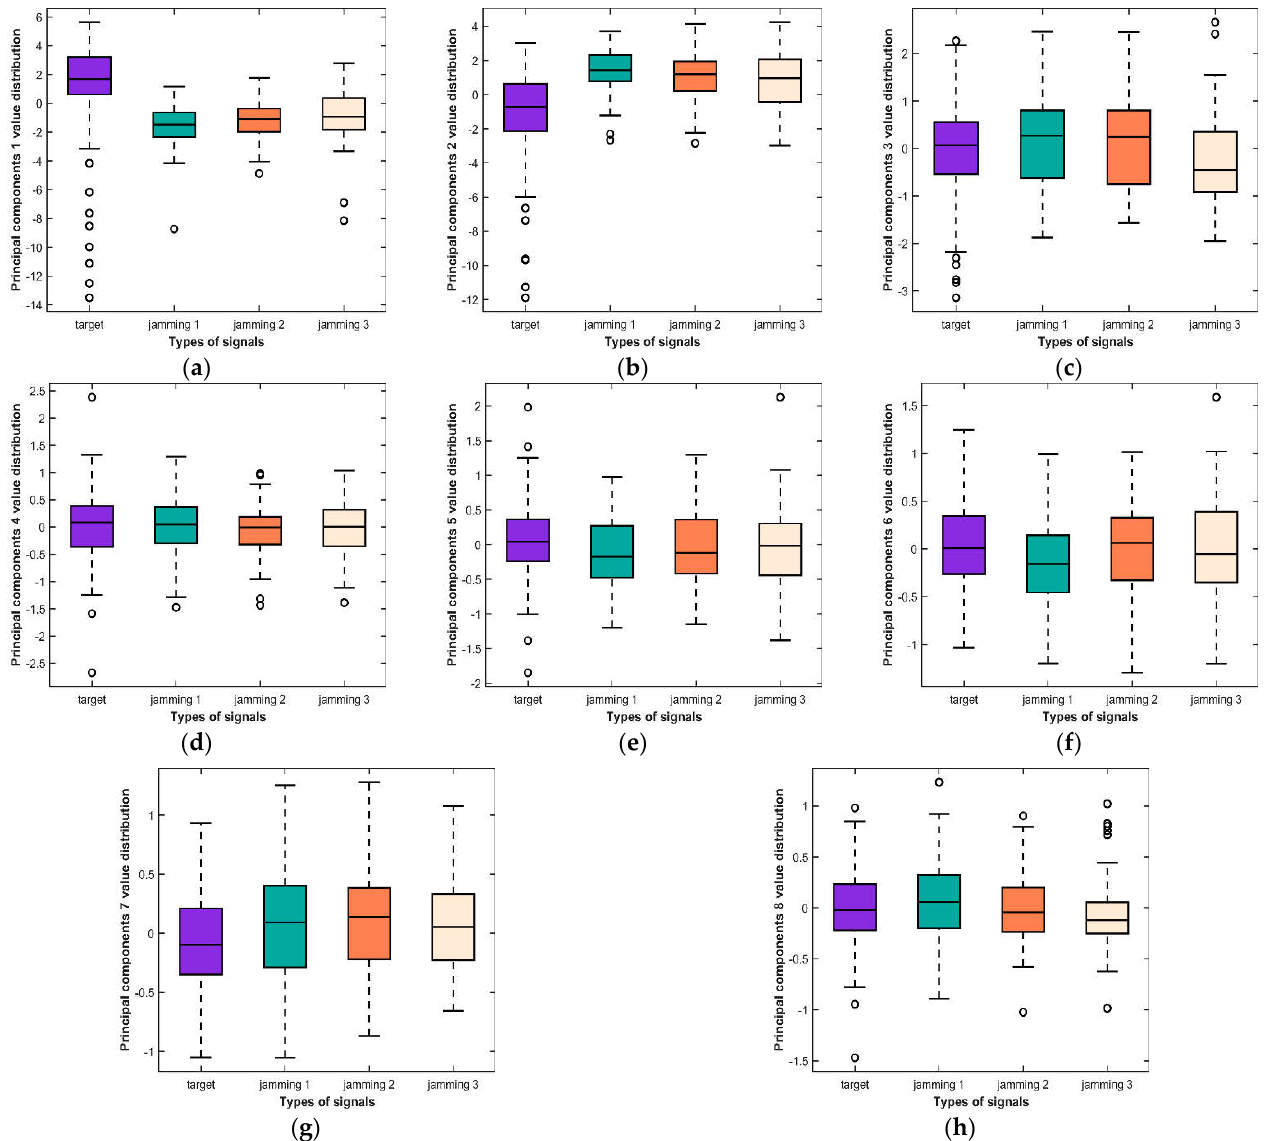
Figure 6. Boxplot of the distribution of the values of each principal component. ( a ) Principal component 1. ( b ) Principal component 2. ( c ) Principal component 3. ( d ) Principal component 4. ( e ) Principal compnent 5. ( f ) Principal component 6. ( g ) Principal component 7. ( h ) Principal component 8.